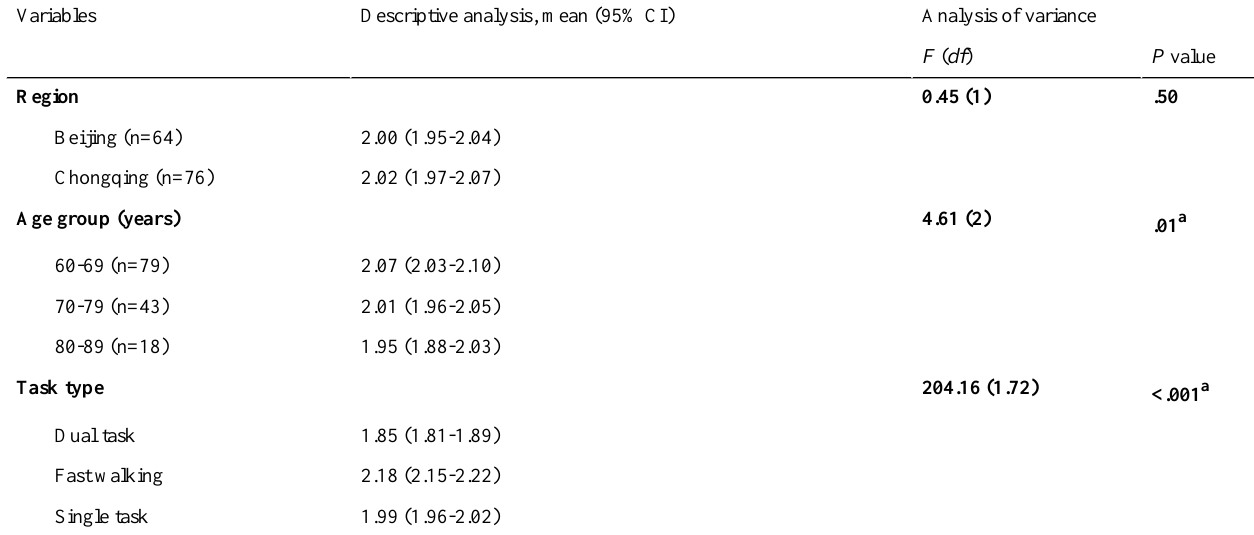
Table 2. Statistics for step frequency.